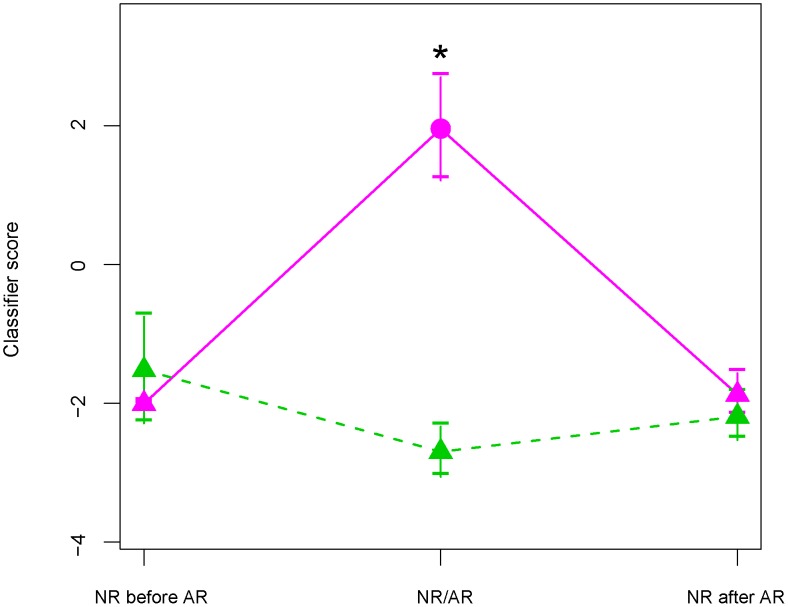
Transition plot.Linear Discriminant Analysis classifier score (Classifier score) when patients transitioned between non-rejection (NR) and acute rejection (AR) episodes. The first consecutive AR time points were averaged (AR, pink solid point) from 7 AR patients. Non-rejection samples from the same patients, before and after AR (“NR before AR” and “NR after AR”) were averaged (pink solid triangle). The average time trend for these samples is represented with a pink solid line. A control curve (dashed green line) was constructed from 9 NR patients matched to AR patients by available time points (green solid triangle). Vertical lines represent standard errors. The asterisk (*) means that the two-sided t-test p value<0.001.